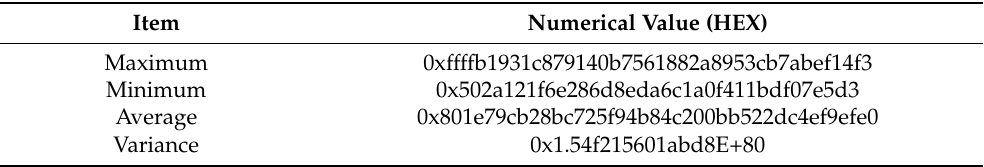
Table 2. Statistical information for 1000